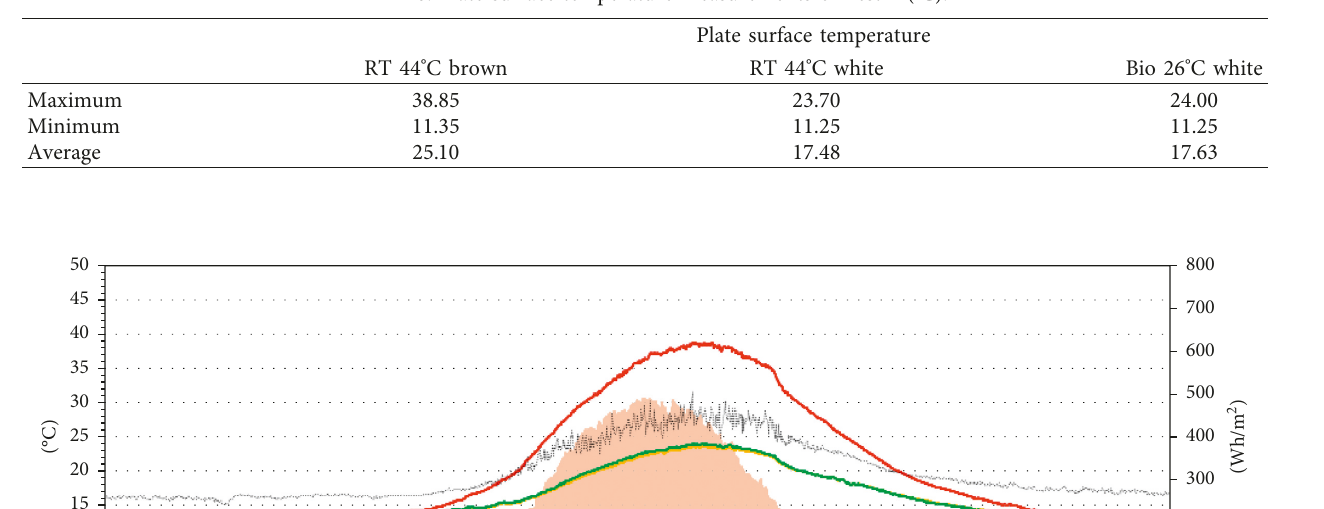
Table 10: Plate surface temperature measurements of Test 2 ( °